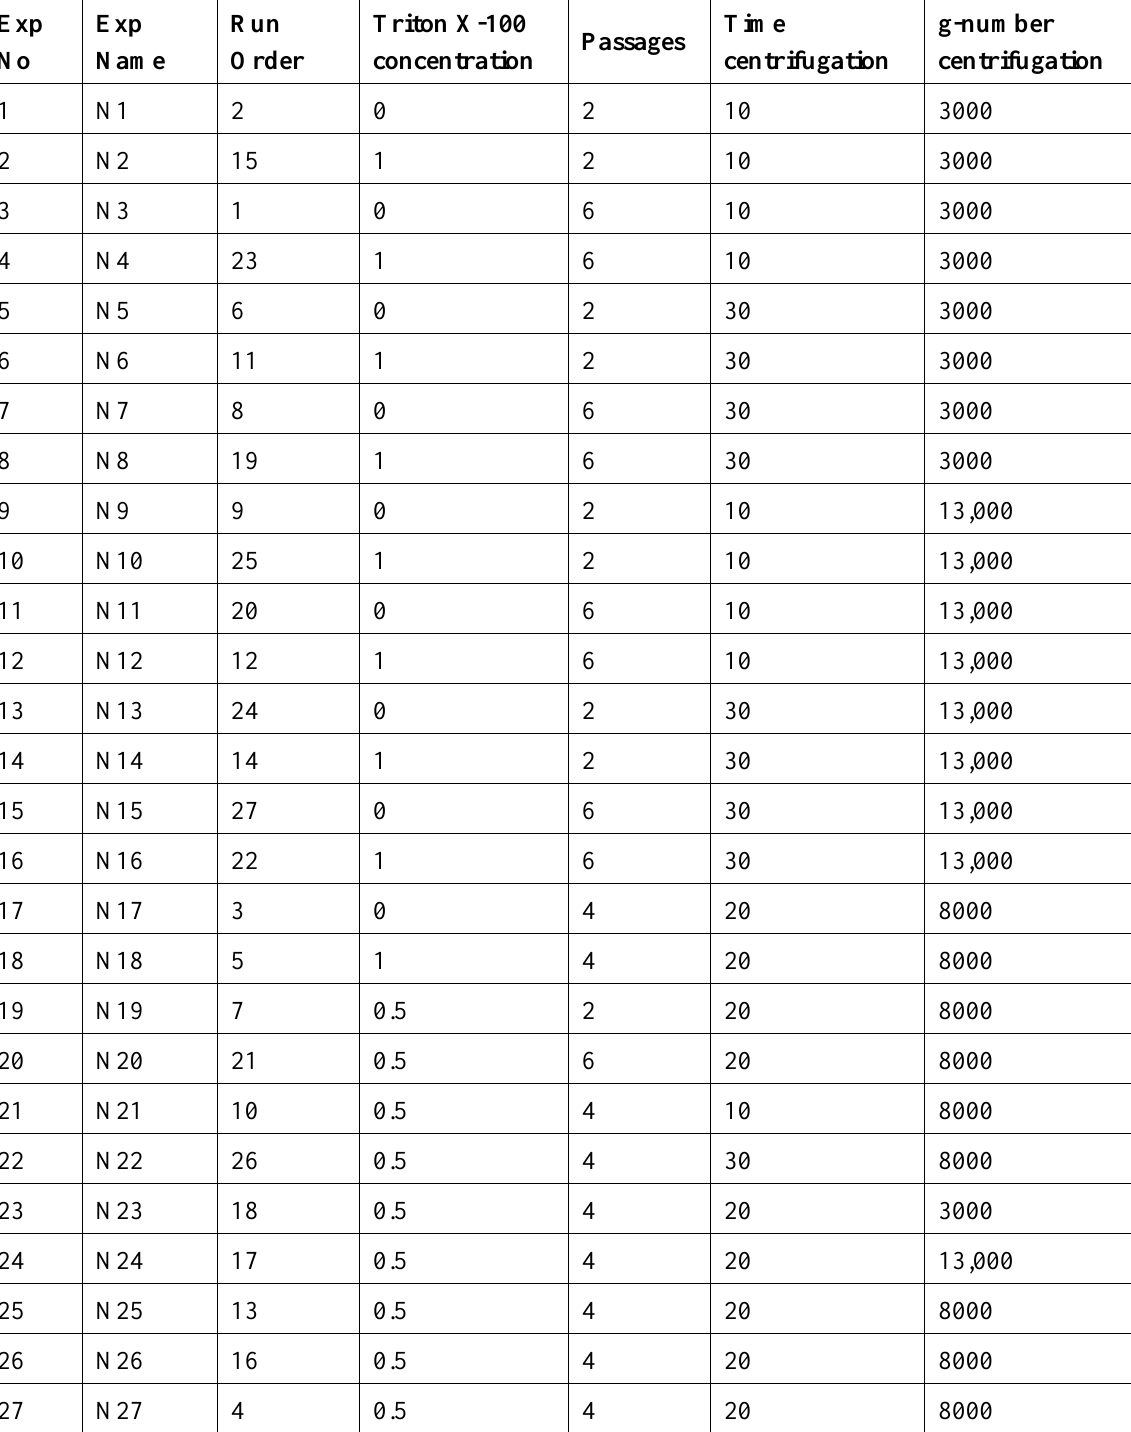
Table 1. Experimental design worksheet. Three levels from each investigated factor were varied according to the experimental setup in a randomized run